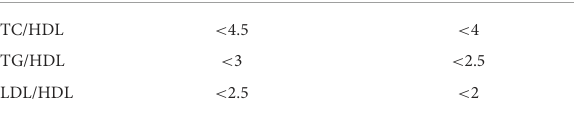
TABLE 1 Normal levels Cholesterol ratios (17, 18).